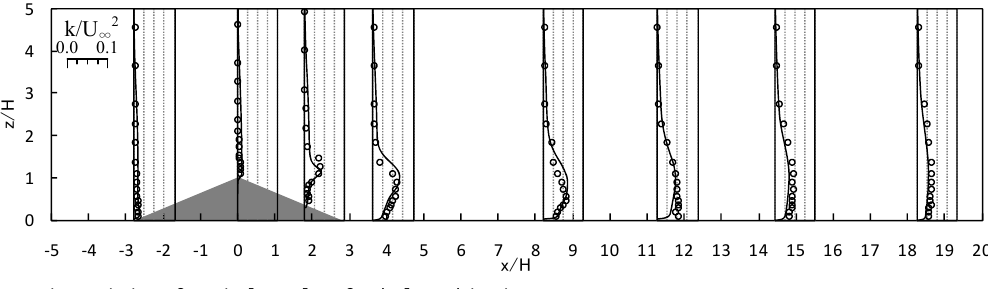
Fig. 3. Streamwise variation of vertical profiles of mean wind velocity.